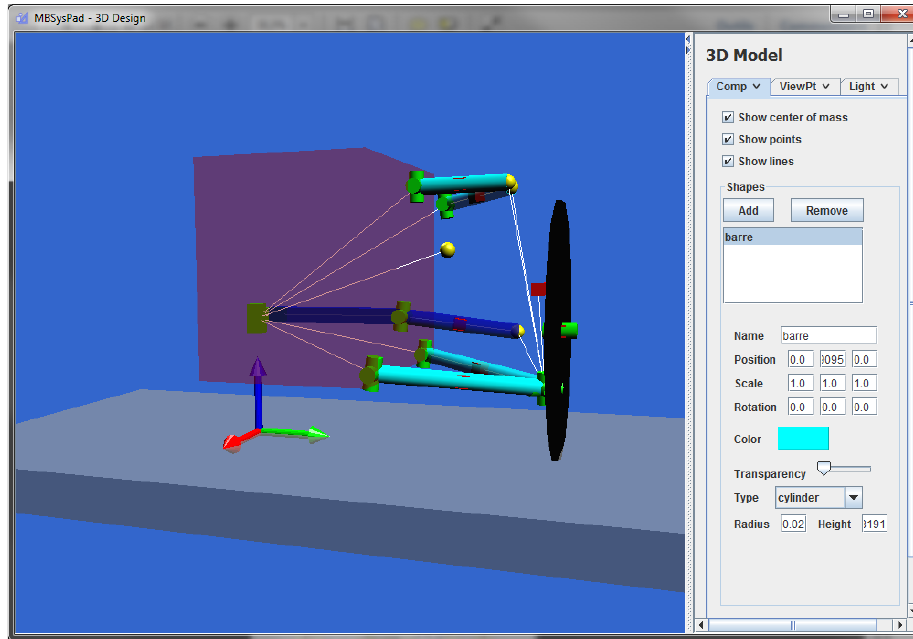
Figure 13. Representation of a 5 points suspension model in MBsysPad 3-D